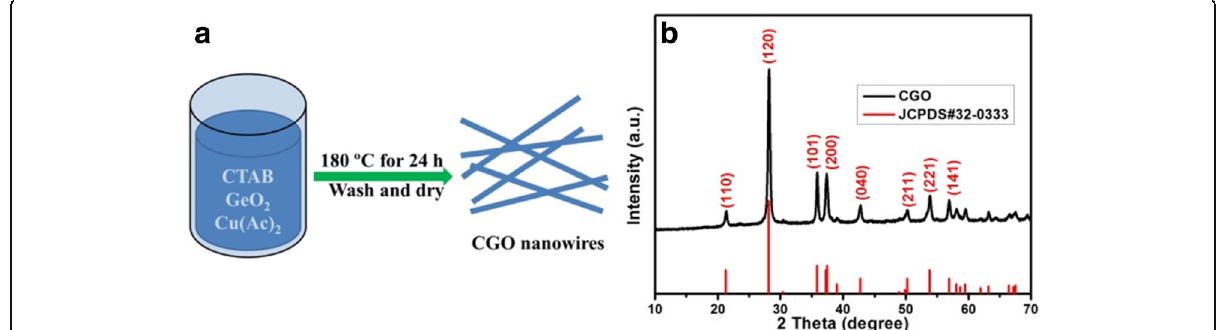
Fig. 1 a Schematic illustration of the preparation and b XRD pattern of the CGO nanowires